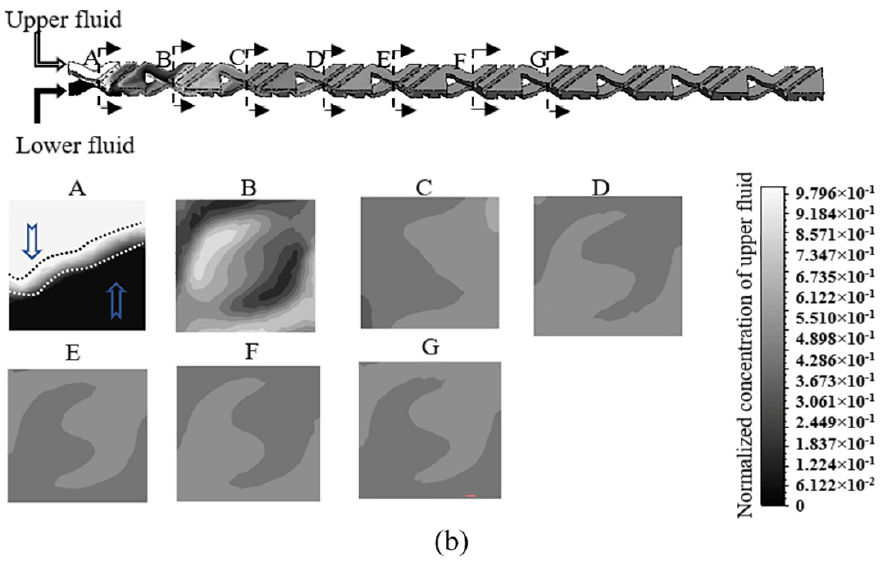
Figure 5. The mass fraction contours of cross-section planes from simulation result at ( a ) Re number of 4.7 and ( b ) Re number of 66.7 for the normal fluid (mesh size 10 µ m).